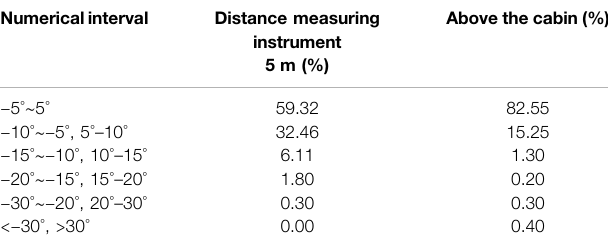
TABLE 3 | Measurement of yaw error at 5 m distance and 0 m from radar. Numericalinterval Distance measuring